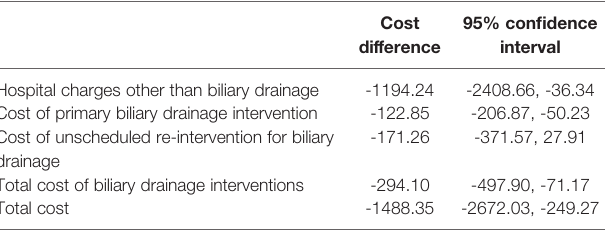
TABLE 3 | Bootstrapped bias-corrected 95% con fi dence intervals for the cost difference between EUS-BD and PTBD (cost of EUS-BD minus that of PTBD).